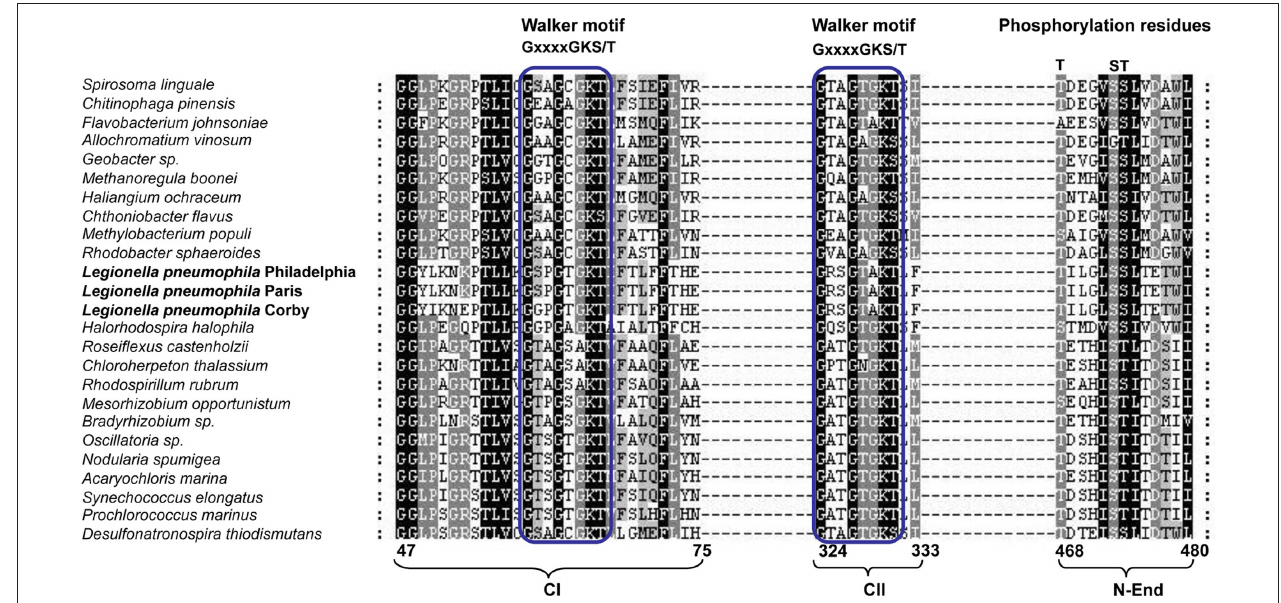
Figure 2 | Alignment of the KaiC sequences from prokaryotes containing both kaiB and kaiC sequences in their genome. Walker motifs and phosphorylation residues are indicated. The numbers below indicate the amino acid position with respect to the full protein sequence. Parentheses below the alignment indicate the location of each motif or residue: CI (first KaiC domain), CII (second KaiC domain), and N-End (N-terminus of the